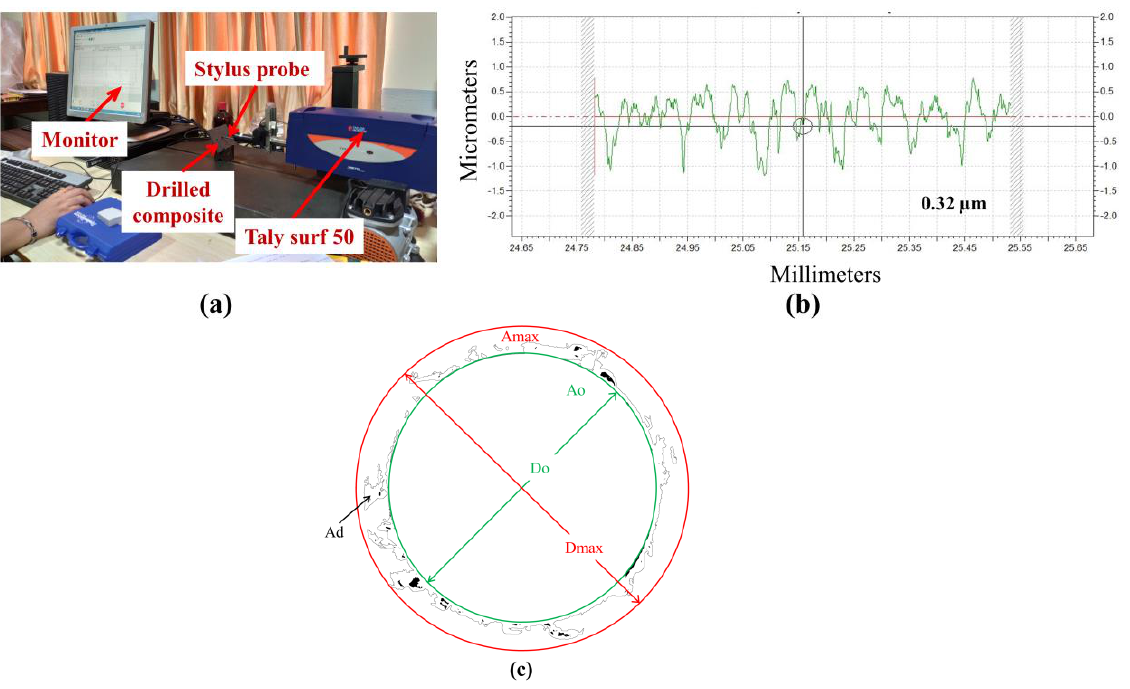
Figure 2. ( a ) Taylor Hobson surface roughness measuring instrument; ( b ) surface roughness cali- bration profile and ( c ) schematics of delamination zone labeled with area and diameter to estimate delamination factor.